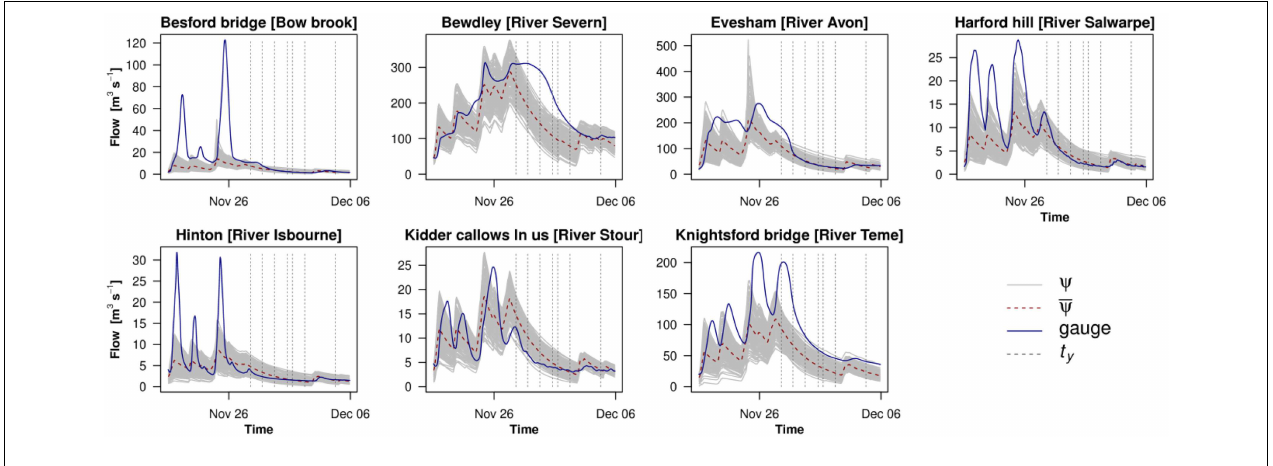
( 9 ) from the hydrologic models, used as input by the flood model. Dashed red lines are the ensemble means ( 9 ). Vertical dashed lines show COSMO-SkyMed overpass times (t y ) (after Garcia-Pintado et al.,